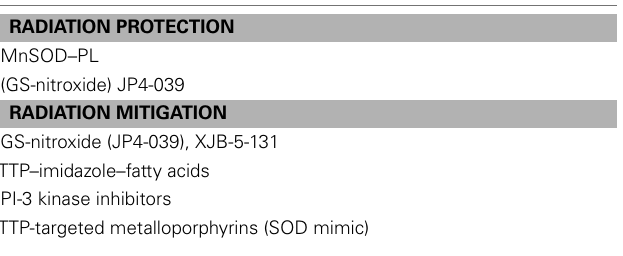
Table 2 | Categories of radioprotective and radiation mitigating agents currently under